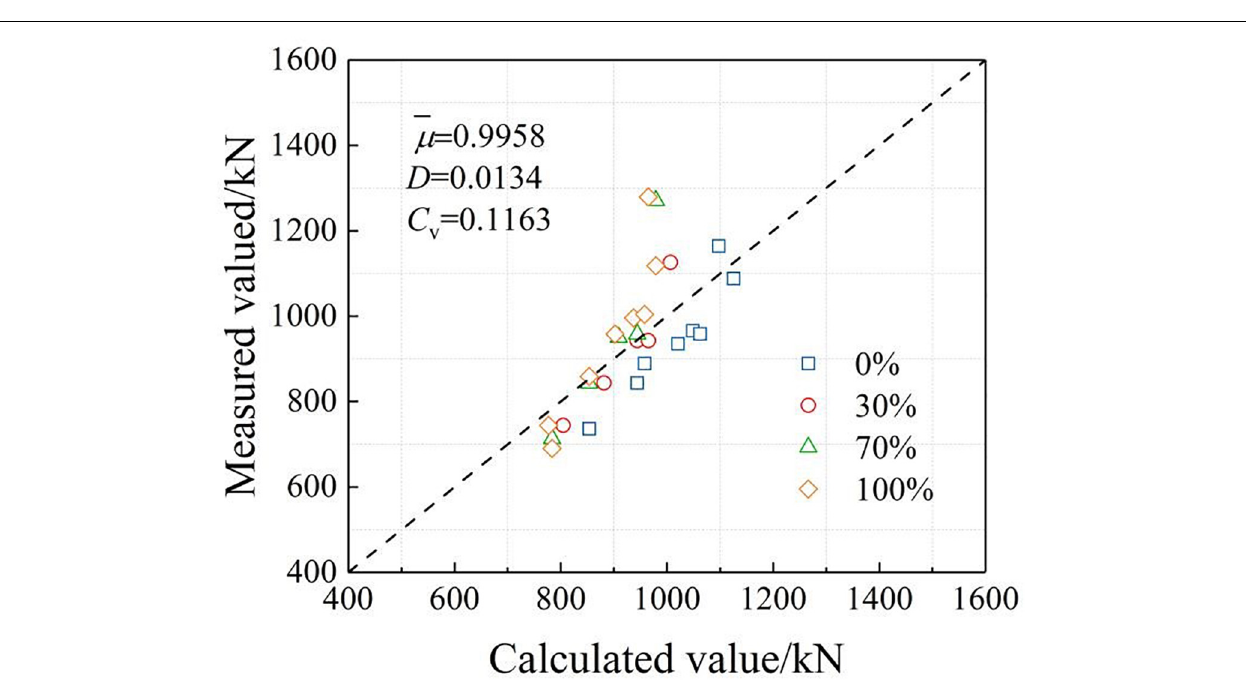
FIGURE 9 | Comparison of calculated and measured of